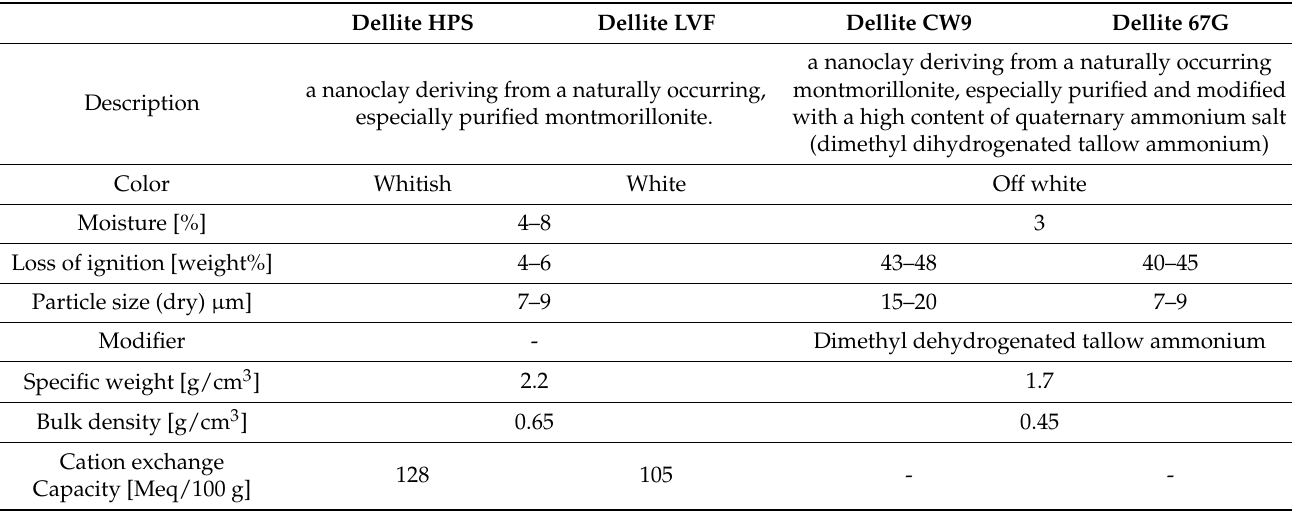
Table 1. Chemical and physical data of the tested fillers.